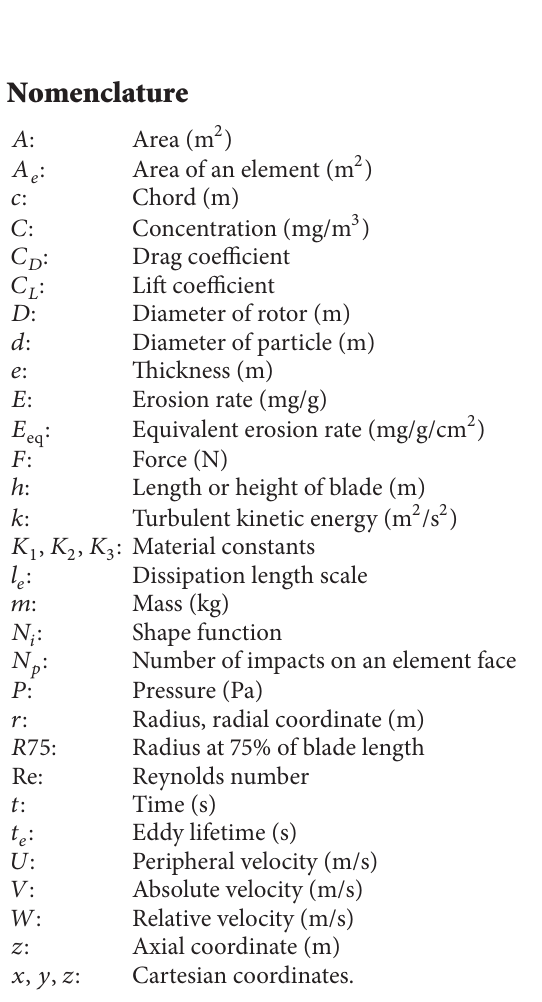
Figure 14: Mass erosion (mg) after one hour of sand ingestion: (a) blade and (b)